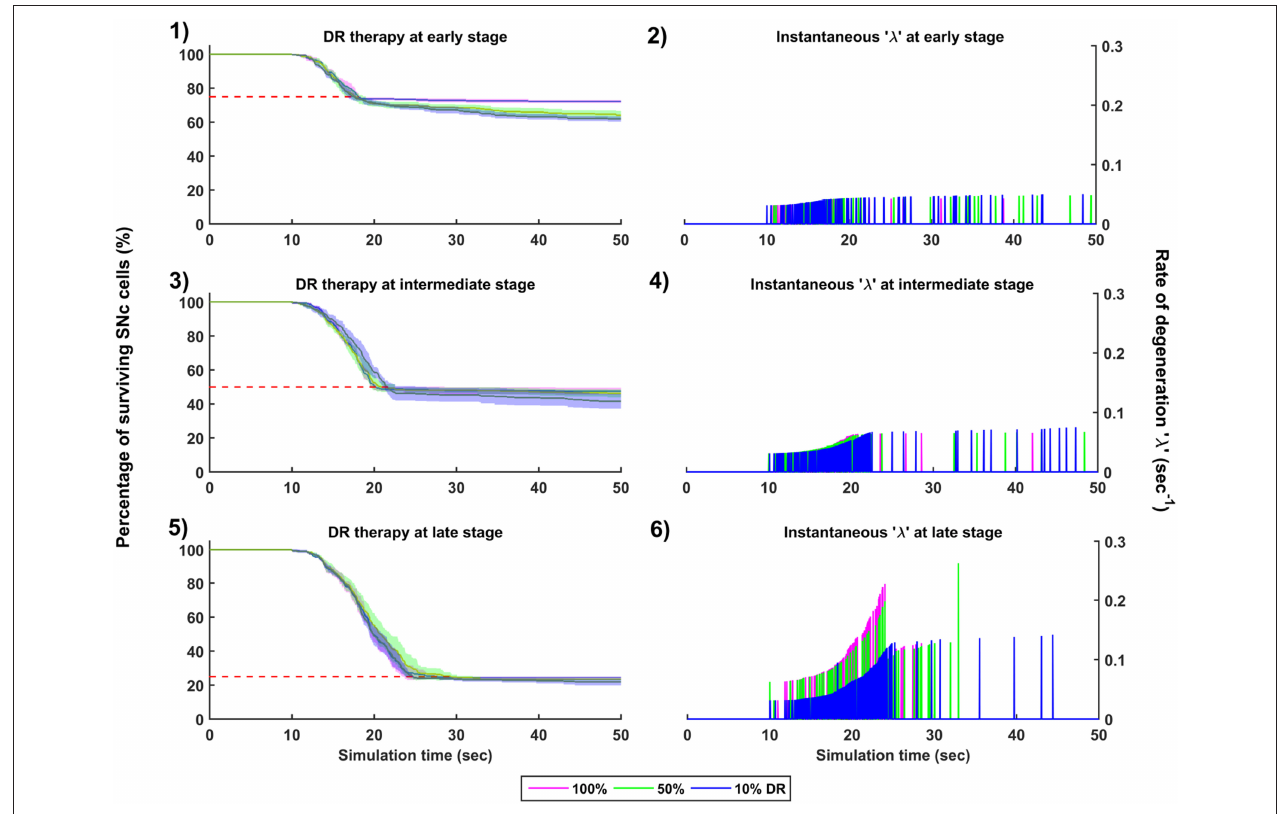
FIGURE 9 | Simulation plots for Dopamine Restoration (DR) therapy. Progression of SNc cell loss for 100, 50, and 10% DR at early (25%) (1) , intermediate (50%) (3) and late (75%) (5) stages of SNc cell loss. Instantaneous rate of degeneration ( λ ) for 100, 50, and 10% DR at early (25%) (2) , intermediate (50%) (4) and late (75%) (6) stages of SNc cell loss. SNc, Substantia Nigra pars